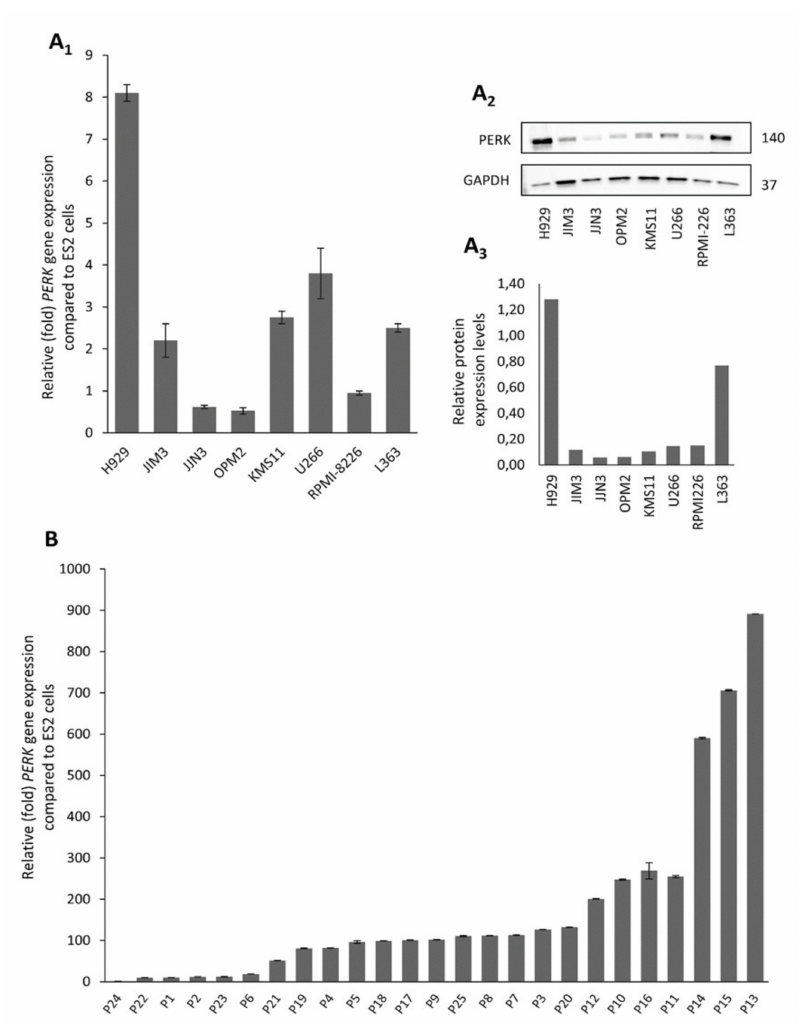
Figure 1. Protein kinase R (PKR)-like ER kinase ( PERK ) mRNA ( A 1 ) and protein ( A 2 , A 3 ) expression levels in multiple myeloma (MM) cell lines; the uncropped Western Blot figure is shown in Figure S4A1, A2. ( B ) PERK mRNA expression in isolated CD138 + cells from selected MM patients ( n =